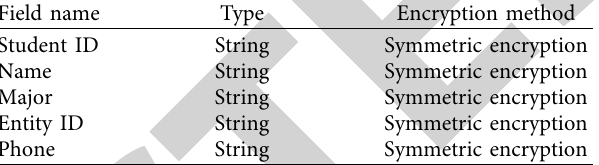
Table 2: Academic